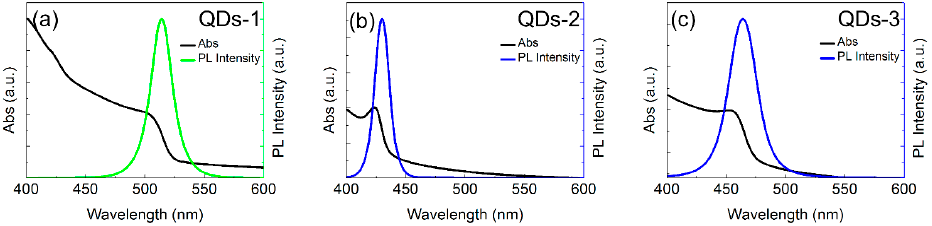
Figure 3. Absorption spectra and photoluminescence (PL) spectra of ( a ) QDs-1; ( b ) QDs-2; and ( c ) QDs-3.